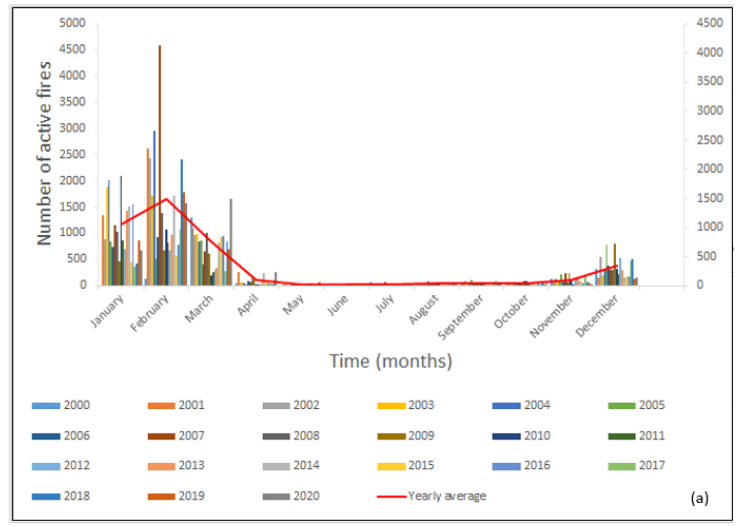
Figure 5. Temporal distribution of active fires in Colombia, by month, from 2000 to 2020.